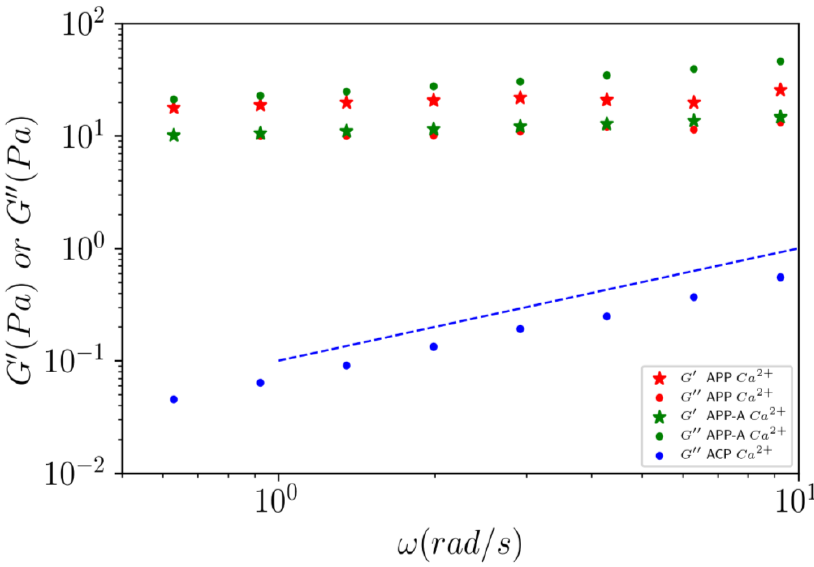
Figure 8. Elastic (G ′ ) and viscous (G ″ ) moduli as a function of the angular frequency ( 𝜔 ) for ACP, APP, and APP-A at 10 g L −1 , against CaCl 2 at 25 °C for an applied oscillatory strain γ = 0.1%. Full dots correspond to viscous modulus G″ (Pa) and stars to the elastic modulus G′ (Pa). No elastic modulus is shown for ACP because it behaves like a Newtonian liquid. Dashed line has a slope as a Newtonian liquid should have for dynamic measurements at a low oscillatory strain. For the samples APP and APP-A, in the absence of CaCl 2 excess, viscous G″ moduli were in the same range of values (data not shown) as ACP and followed a linear behavior in angular frequency, indicating a Newtonian behavior and confirming the results observed in Figure 6.